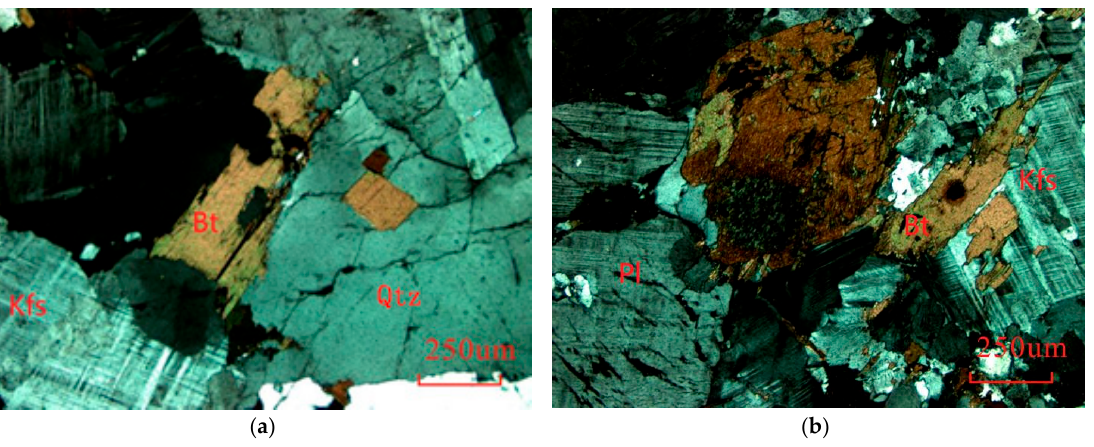
Figure 2. Two cross-polarized light photos of thin sections showing the mineralogical composition of test specimens. ( a ) Section I; ( b ) Section II.